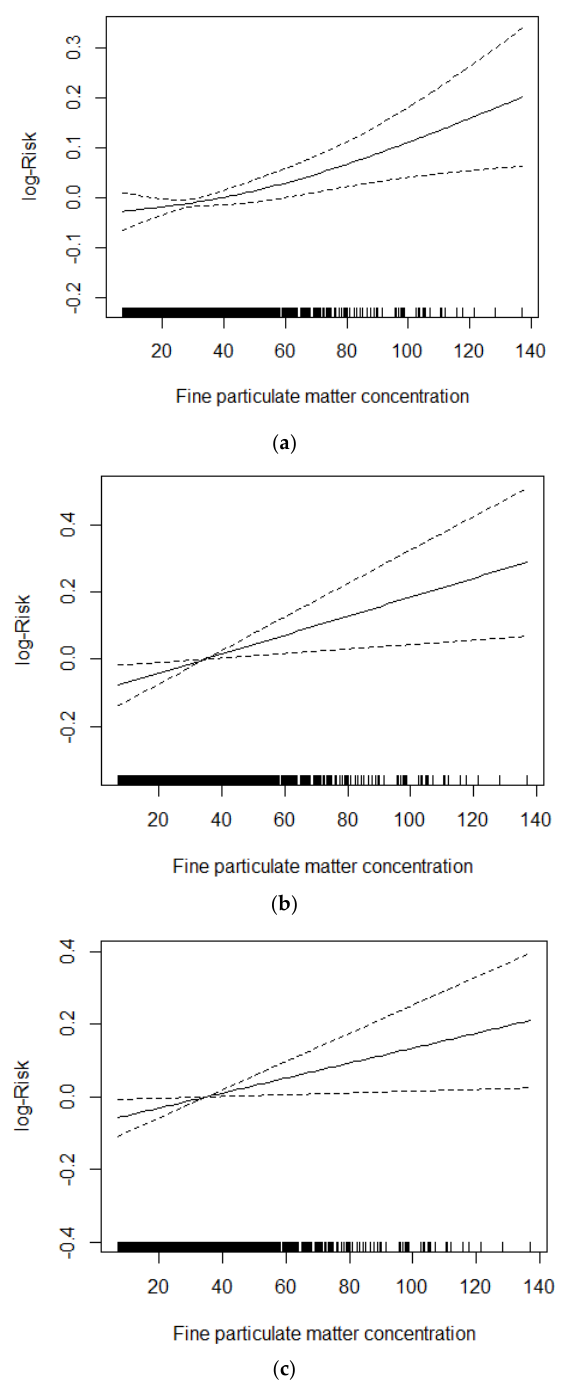
Figure 3. ( a ) Association between daily lag5 cardiovascular disease mortality and PM 2.5 concentration ( µ g/m 3 ) considered in the generalized additive model (GAM). ( b ) Association between daily lag2 IHD mortality and PM 2.5 concentration ( µ g/m 3 ) considered in the GAM. ( c ) Association between daily lag4 EVD mortality and PM 2.5 concentration ( µ g/m 3 ) considered in the